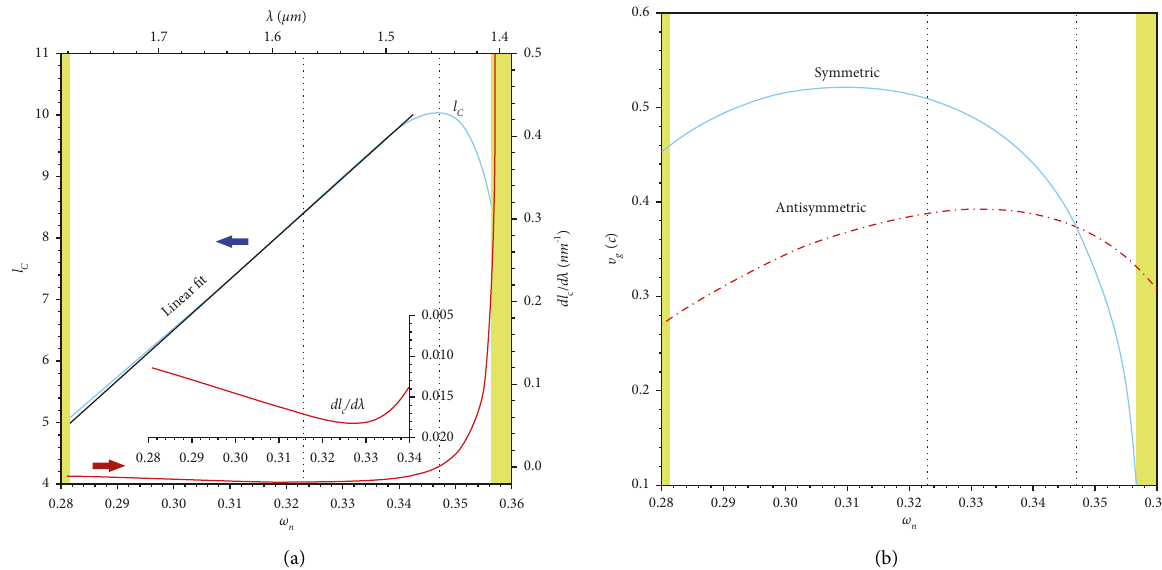
Figure 4: (Color online) variation of the normalized coupling length, accompanied by its first derivative (a) and normalized group velocities (b) of the surface modes with frequency. Inset in (a) presents a closer look for ω n which FDTD simulations are performed, whereas the hatched rectangular areas denote the frequency ranges over which surface mode coupling is not